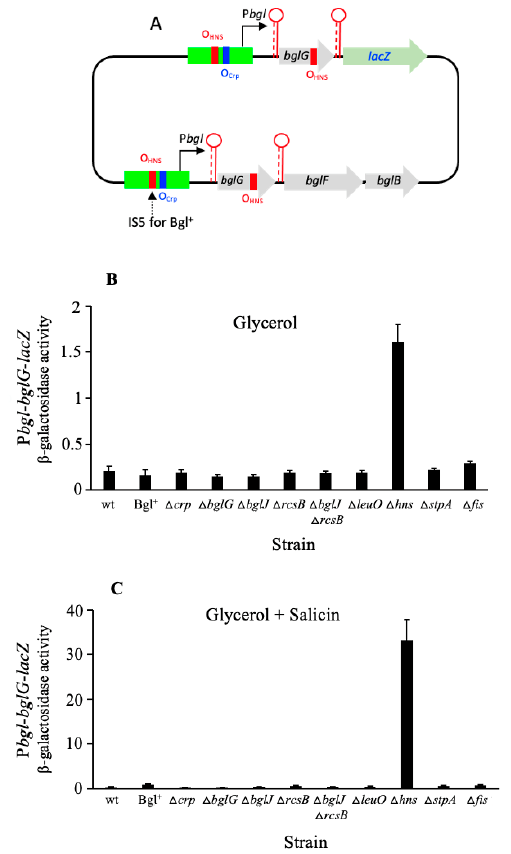
Figure 2. The bgl operon activities in the wild type and its various genetic backgrounds. Culture preparation, sample collection, and β‐ galactosidase assays were carried out as in Figure 1 (see Section 4). ( A ) Diagram showing the lacZ transcriptional reporter for the entire regulatory region of the bgl operon (P bgl ‐ bglG ‐ lacZ ). The region carrying P bgl and bglG , including both terminators ( − 205 to 1127 relative to the bglG transcriptional start site), was fused upstream of the lacZ ’s RBS (that is, TTTCACACAGGAAACAGCT) at the lac locus. Strain Bgl + carries an IS5 element oriented in the inverse direction and inserted at − 207.5 upstream of the bglG translation start site. For all other strains, the native bgl operon remains unchanged. For both the operon reporter and the native bgl operon, the blue bars represent the Crp binding sites (O Crp ) while the red bars represent the proposed H ‐ NS binding sites (O HNS ). ( B ) bgl operon activities in cells grown in M63 with glycerol as the primary carbon source. ( C ) bgl operon activities in cells grown with glycerol and salicin as carbon sources.